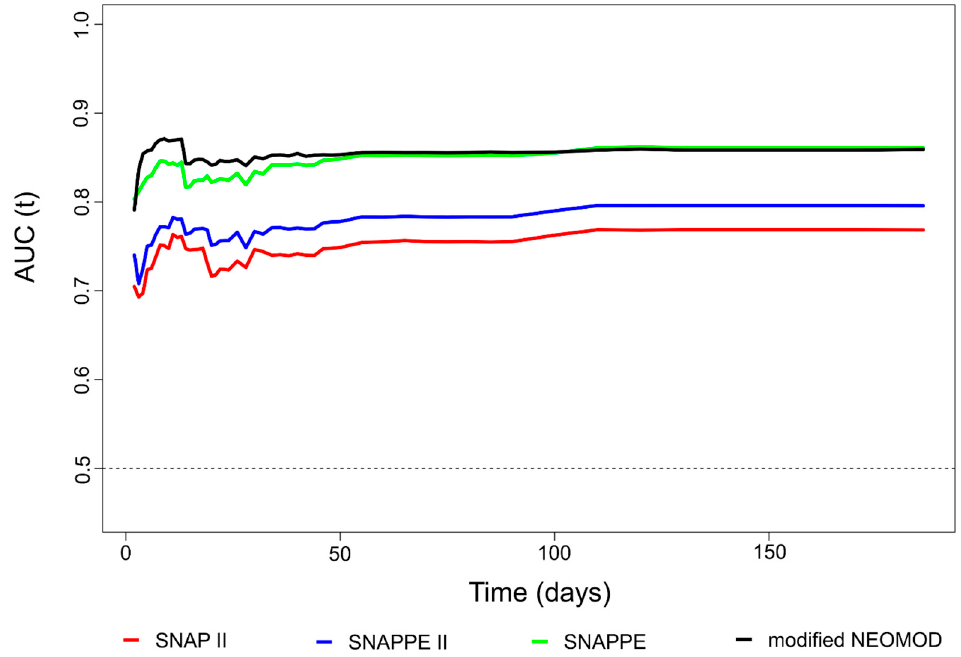
Figure 3. Over time prognostic performance of the four scores in predicting death. The modified NEOMOD score performed similarly to SNAPPE with no statistically significant difference at any time point (Table 2). Table 2. Area under curve (AUC) showing the prognostic power of the mortality indexes over time. Time (days) a